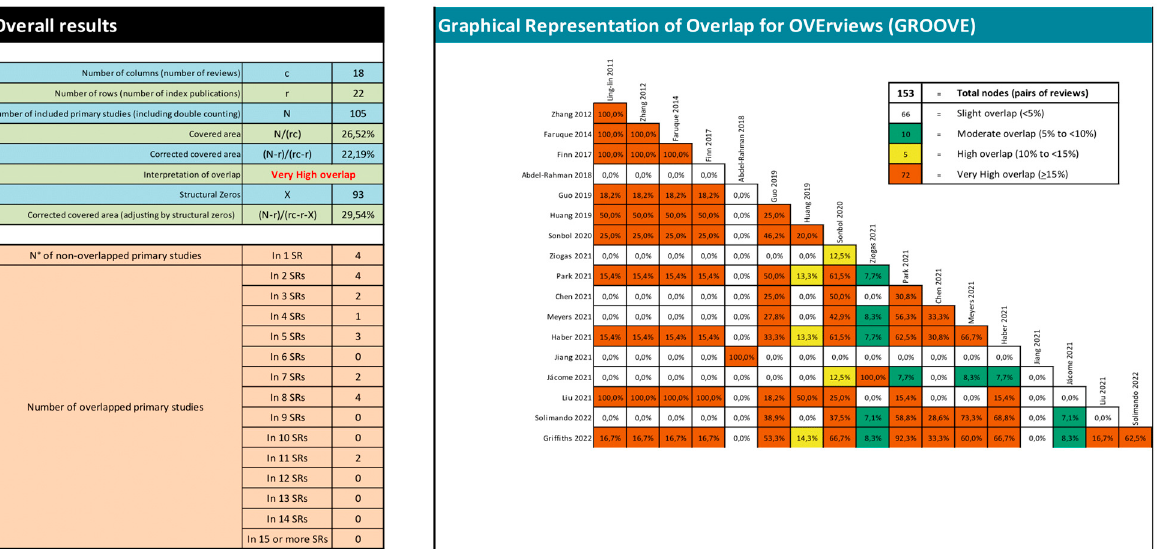
Figure 3. ‘ Graphical representation of overlap’ (GROOVE) assessment for each possible pair of SRs.